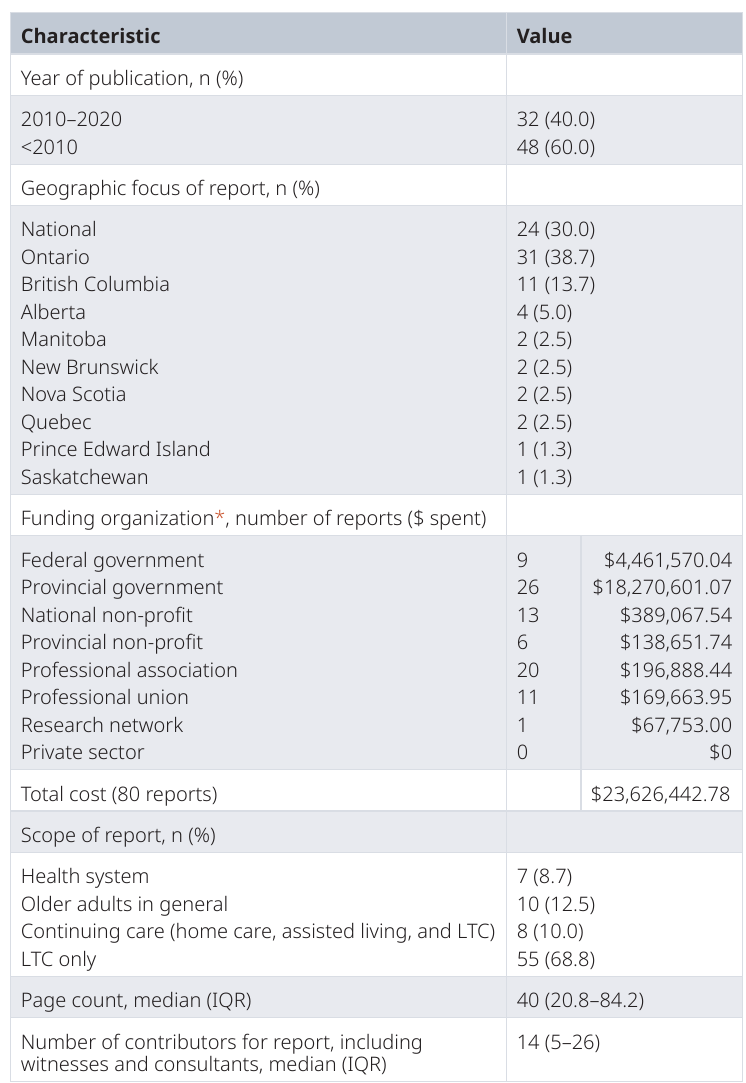
Table 1. Report characteristics for 80 long-term care (LTC) reports in Canada from 1998–2020. The year of publication, geographic focus, funding organization, scope (topics covered), page count and number of contributors were extracted for each report. Costs were adjusted to 2020 Canadian dollar values. IQR, interquartile